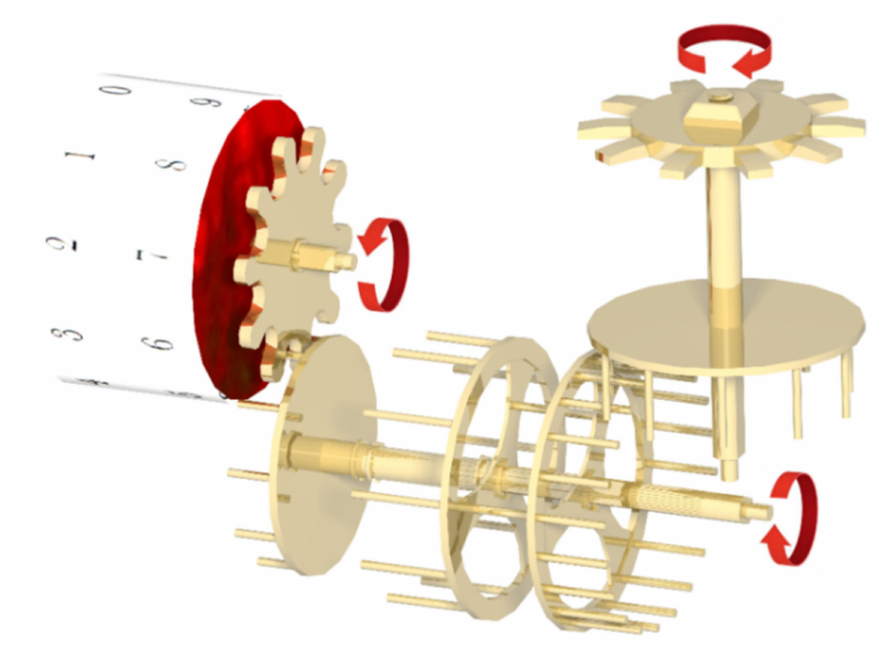
Figure 10. Transmission of the main